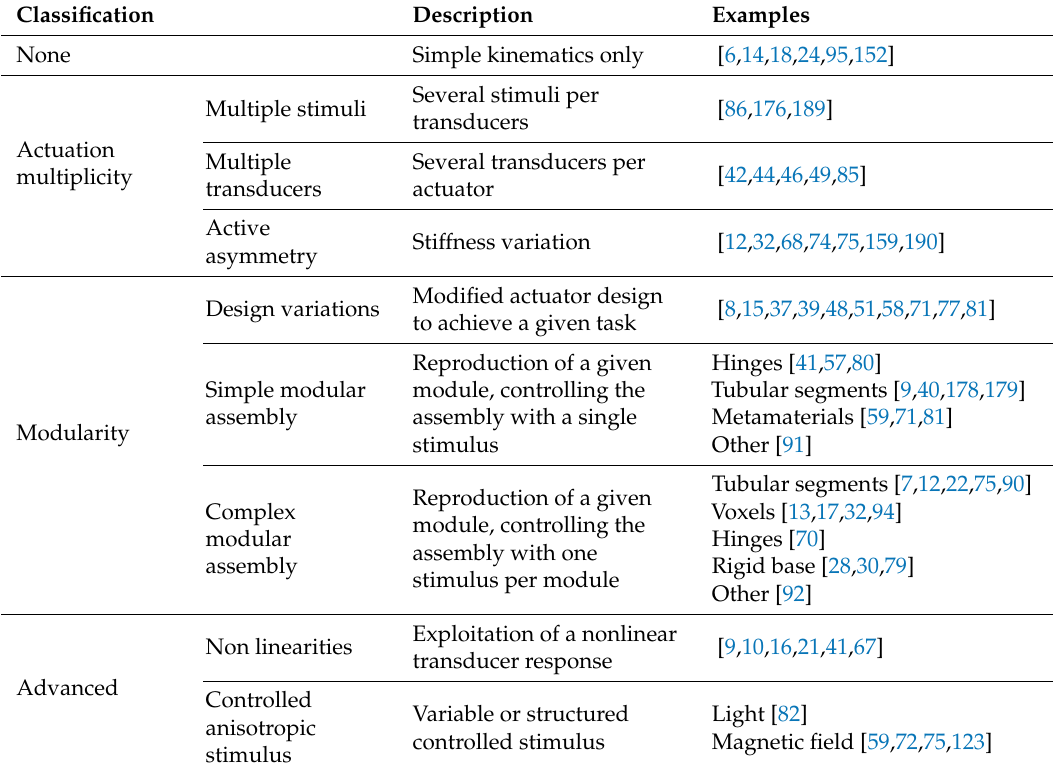
Table 3. Complex motion generation strategies